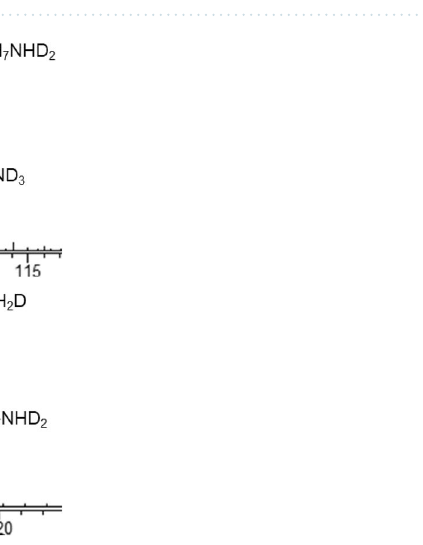
Figure 2. Full-scan and multistage mass spectra of m/z 106 from toluene ( a ), multistage mass spectra of protonated di- p -tolylamine ( b ), the generative method for the authentic p -methylphenylnitrenium ( c ).